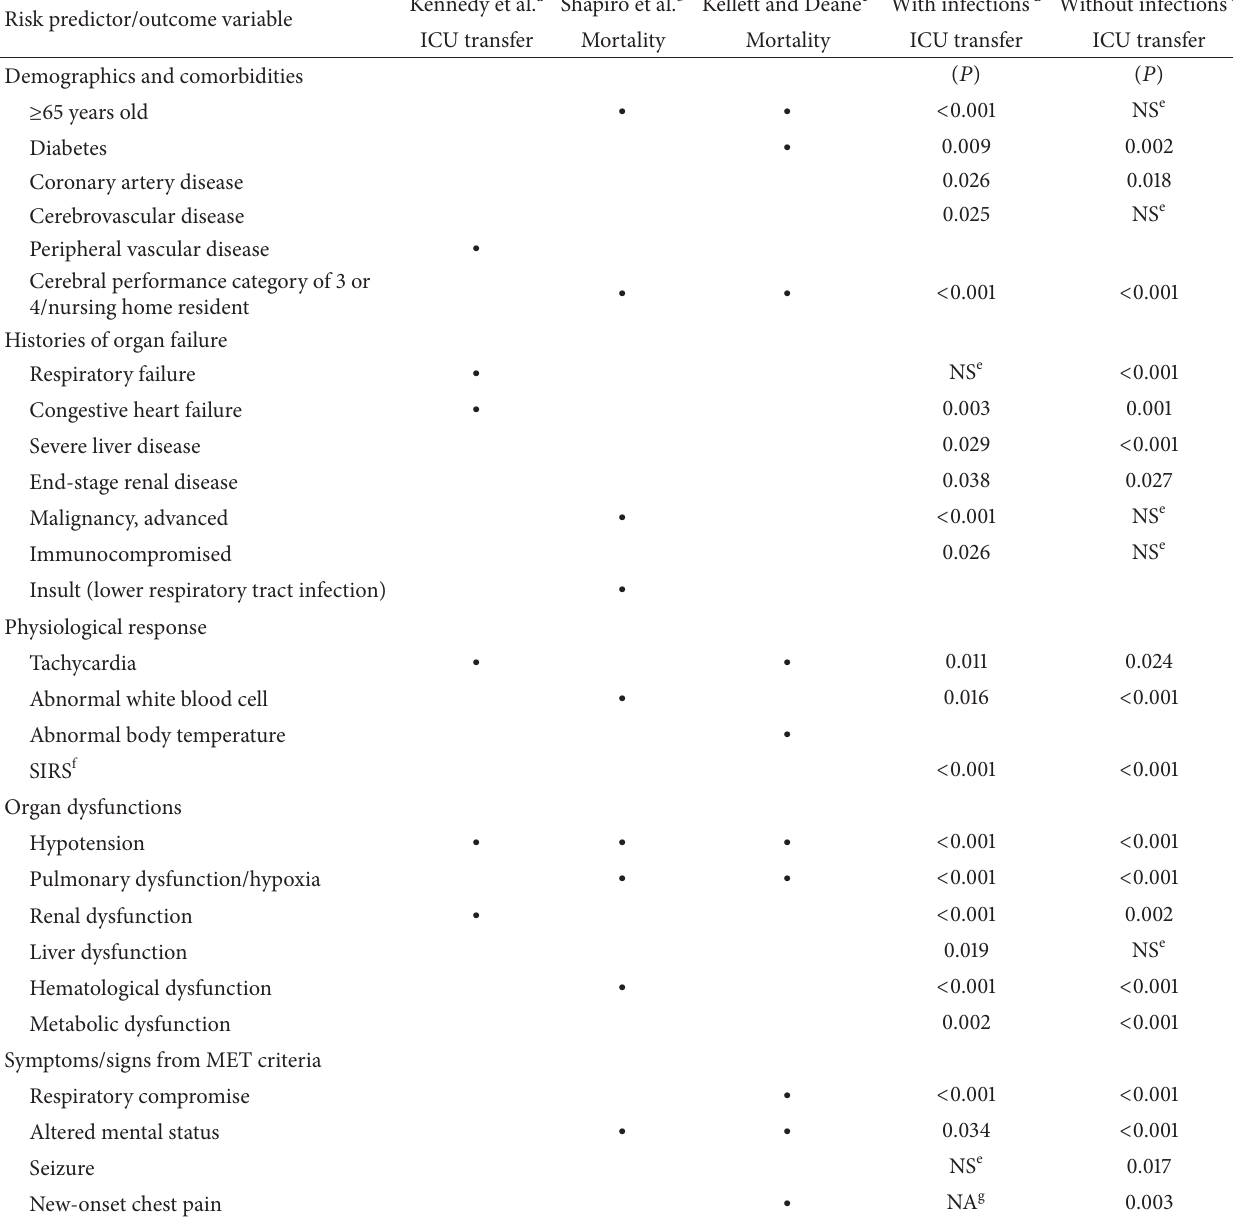
Table 5: Summary of variables predictive of deterioration/mortality in the literature and present study. Risk predictor/outcome